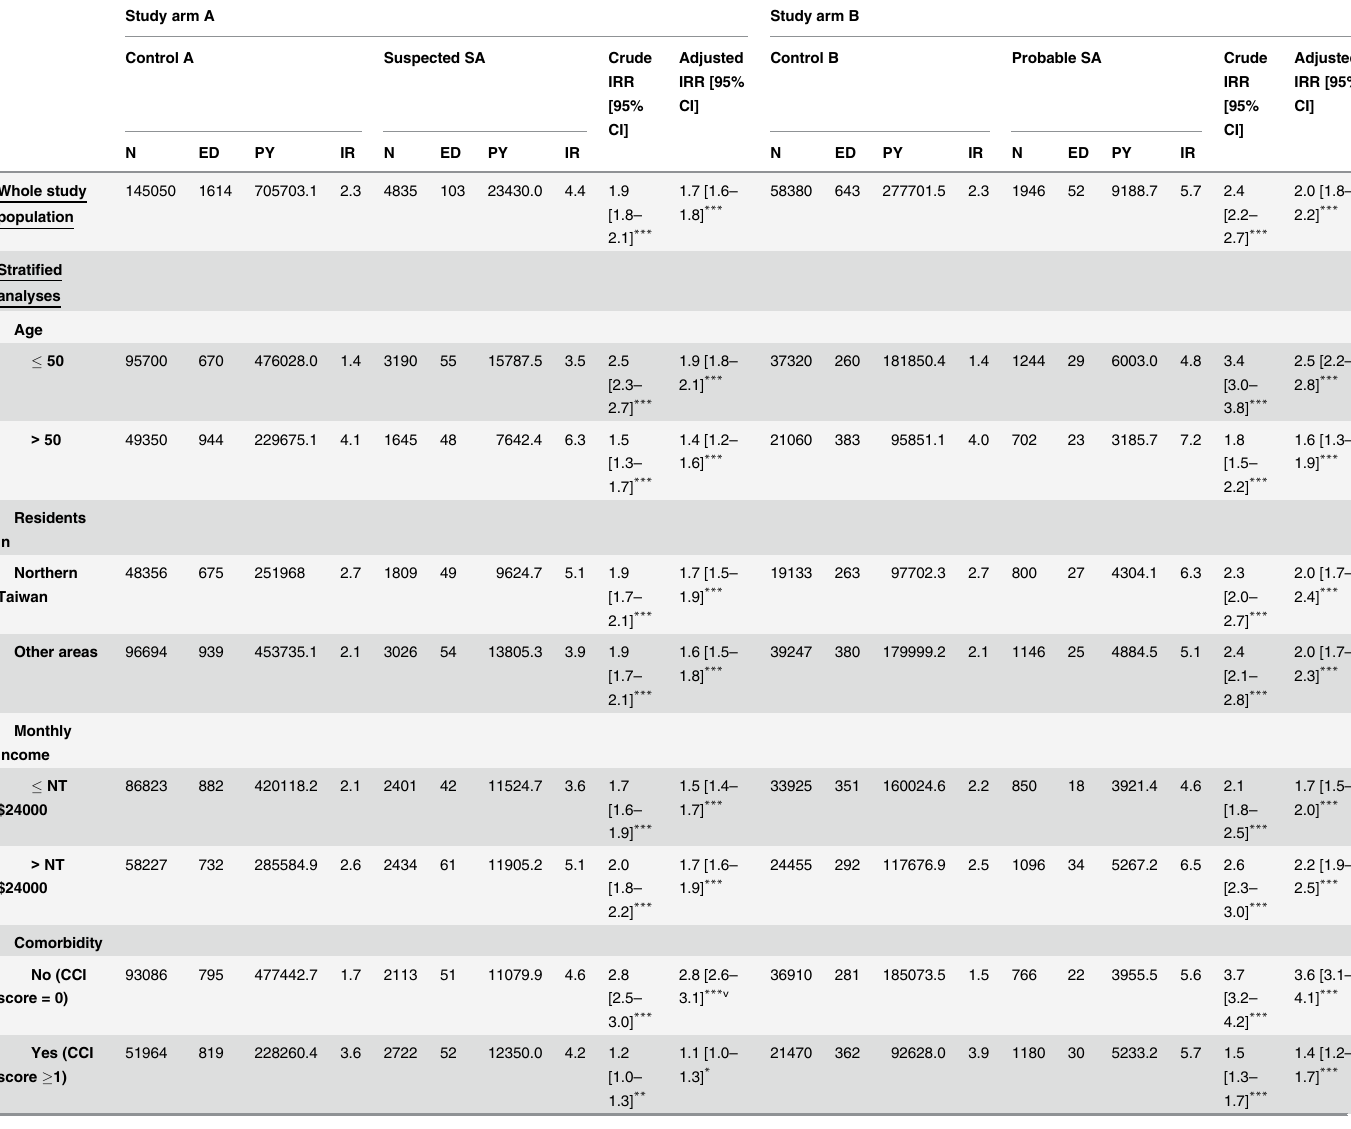
Table 2. Incidence rate of erectile dysfunction after the index date in each